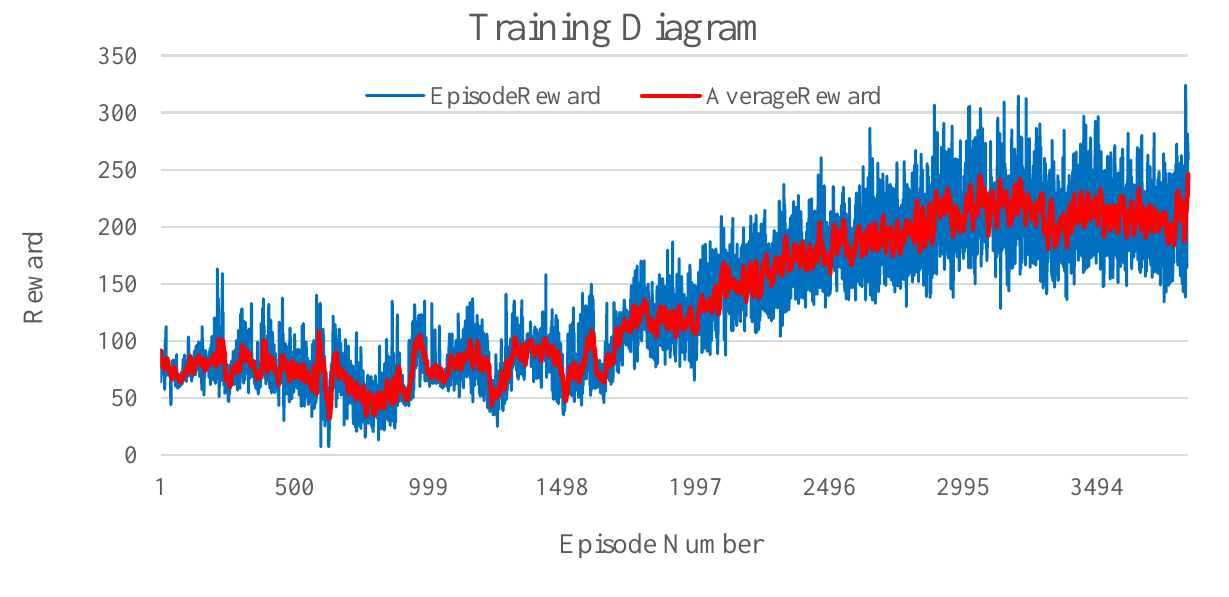
Figure 3. Training diagram.